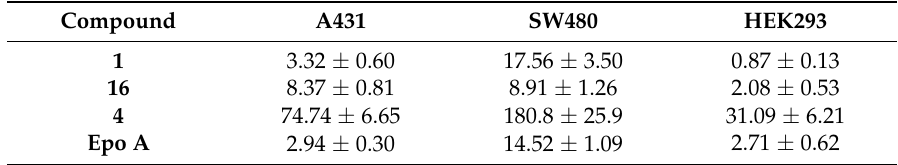
Table 2. Antiproliferative activity of epothilone analogs 1 and 16 and of epothilone-CE11 conjugate 4 against human cancer cell lines (IC 50 [nM]) 1